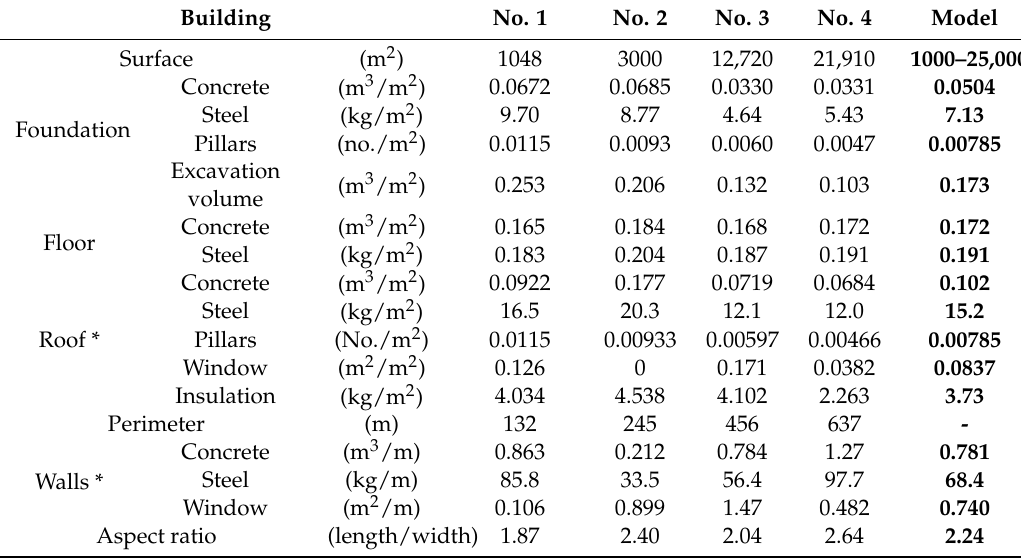
Table 2. Properties of the four selected buildings and values used for the model, grouped as surface- and perimeter-scaling